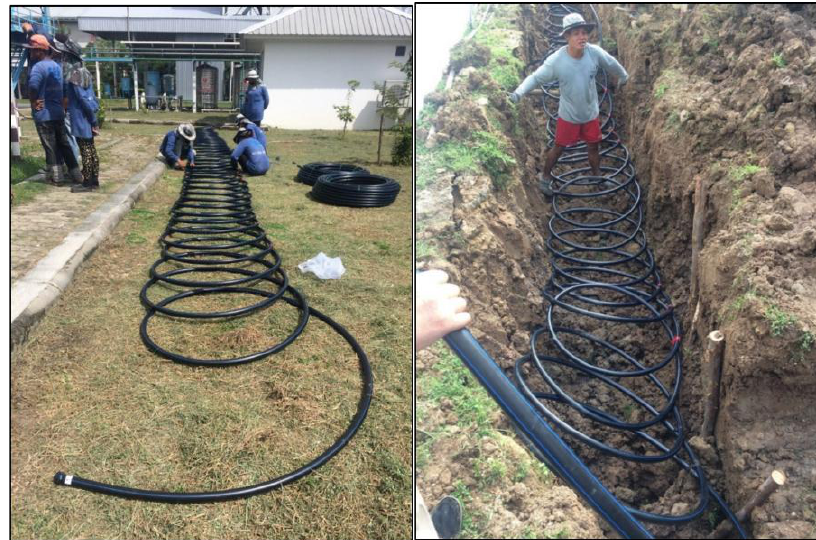
Figure 4. Carpet-type heat exchanger installation.